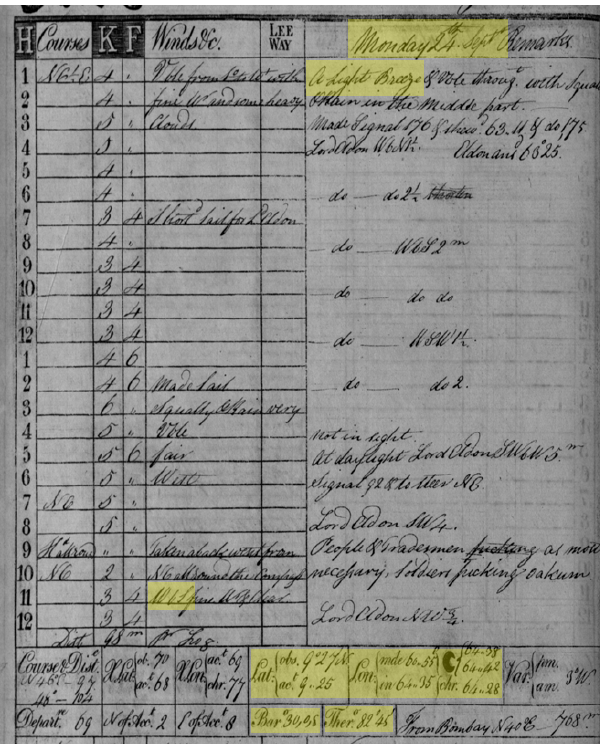
Fig.2. LogbookofEICshipCarmarthenfor24thSeptember1810. Ship’sdaysrunfromnoontonoon12hoursaheadofthecivilday,so Fig. 2. Logbook of EIC ship Carmarthen for 24 September 1810. thiscoverstheafternoonofthe23rdandthemorningofthe24th. Foreachhourthereisspacetoentertheship’scourse,itsspeed(inKnots and Fathoms), and the wind direction. To the right of this table is a section for general remarks (which almost always includes reference Ship’s days run from noon to noon 12h ahead of the civil day, so tothewindspeed); andatthebottomisatableofsummarydatafortheday. Theelementsdigitisedarehighlightedinyellow. fromtopto bottomtheyare: thedate(September24th);thewindforce(alightbreeze—Beaufortforce2),thewinddirection(WestbySouth- 258 . 75 ◦ this covers the afternoon of the 23rd and the morning of the 24th. magnetic),thenoonposition(9degrees27minutesNorth,64degrees28minutesEast),thebarometricpressure(30.05inchesofmercury) For each hour there is space to enter the ship’s course, its speed (in andtheairtemperature(82degrees45minutes— 82 . 75 ◦ Fahrenheit). Knots and Fathoms), and the wind direction. To the right of this ta- ble is a section for general remarks (which almost always includes reference to the wind speed); and at the bottom is a table of sum- mary data for the day. The elements digitised are highlighted in yel- low. From top to bottom they are as follows: the date (24 Septem- ber); the wind force (a light breeze – Beaufort force 2); the wind direction (West by South – 258.75 ◦ magnetic); the noon position (9 degrees 27min North, 64 degrees 28min East); the barometric pres- sure (30.05 inches of mercury); and the air temperature (82 degrees 45min – 82.75 ◦